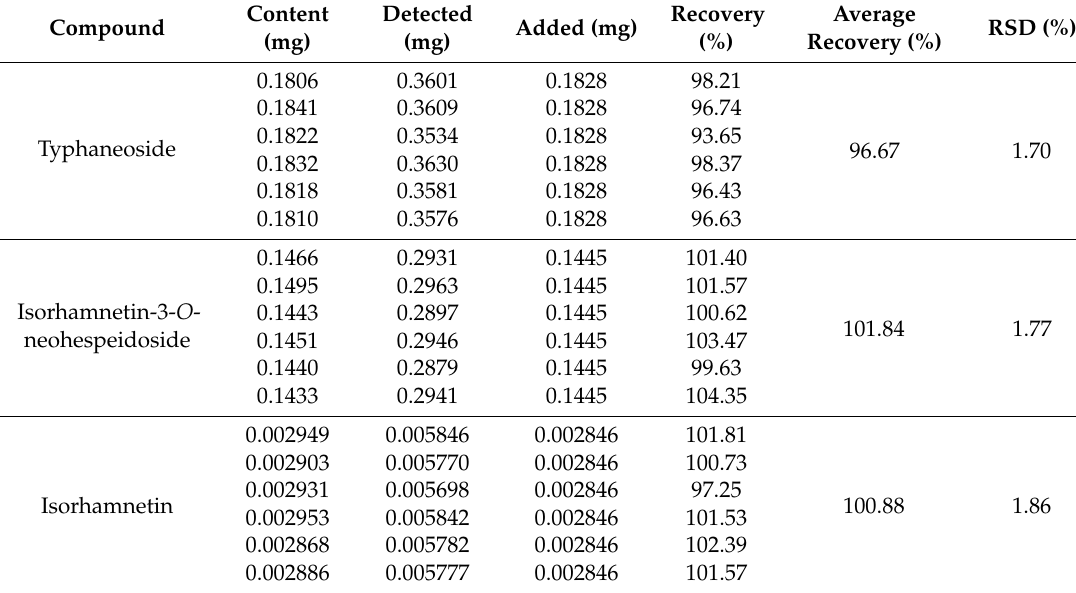
Table 4. Recovery of the three